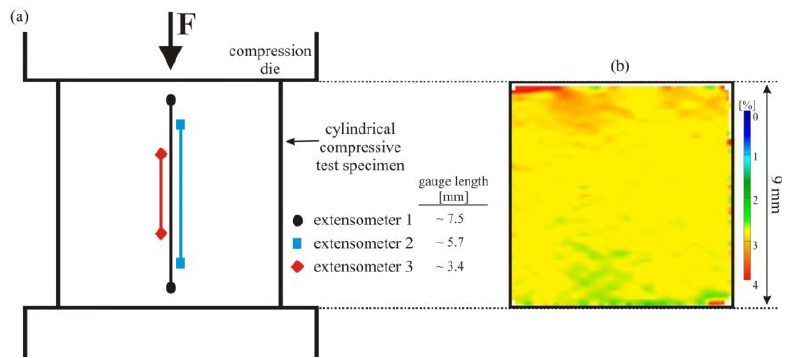
Figure 5. ( a ) Schematic representation of the cylindrical compressive test specimen; ( b ) axial surface strain field recorded at a macroscopic strain of about 3%. Three virtual extensometers (again located next to each other for a better overview) were used under simple compression, where the martensitic transformation proceeds homogeneously on a macroscopic scale without distinct strain localization.